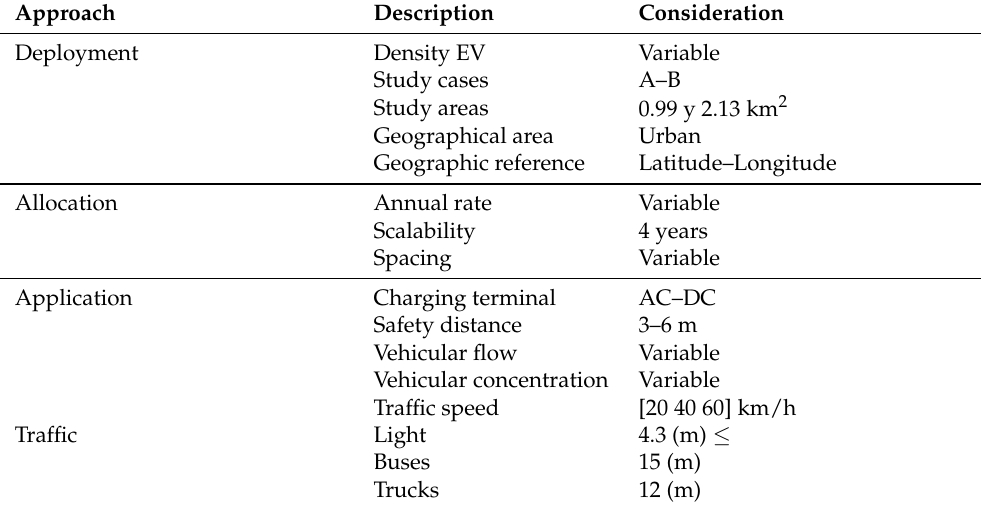
Table 5. Simulation